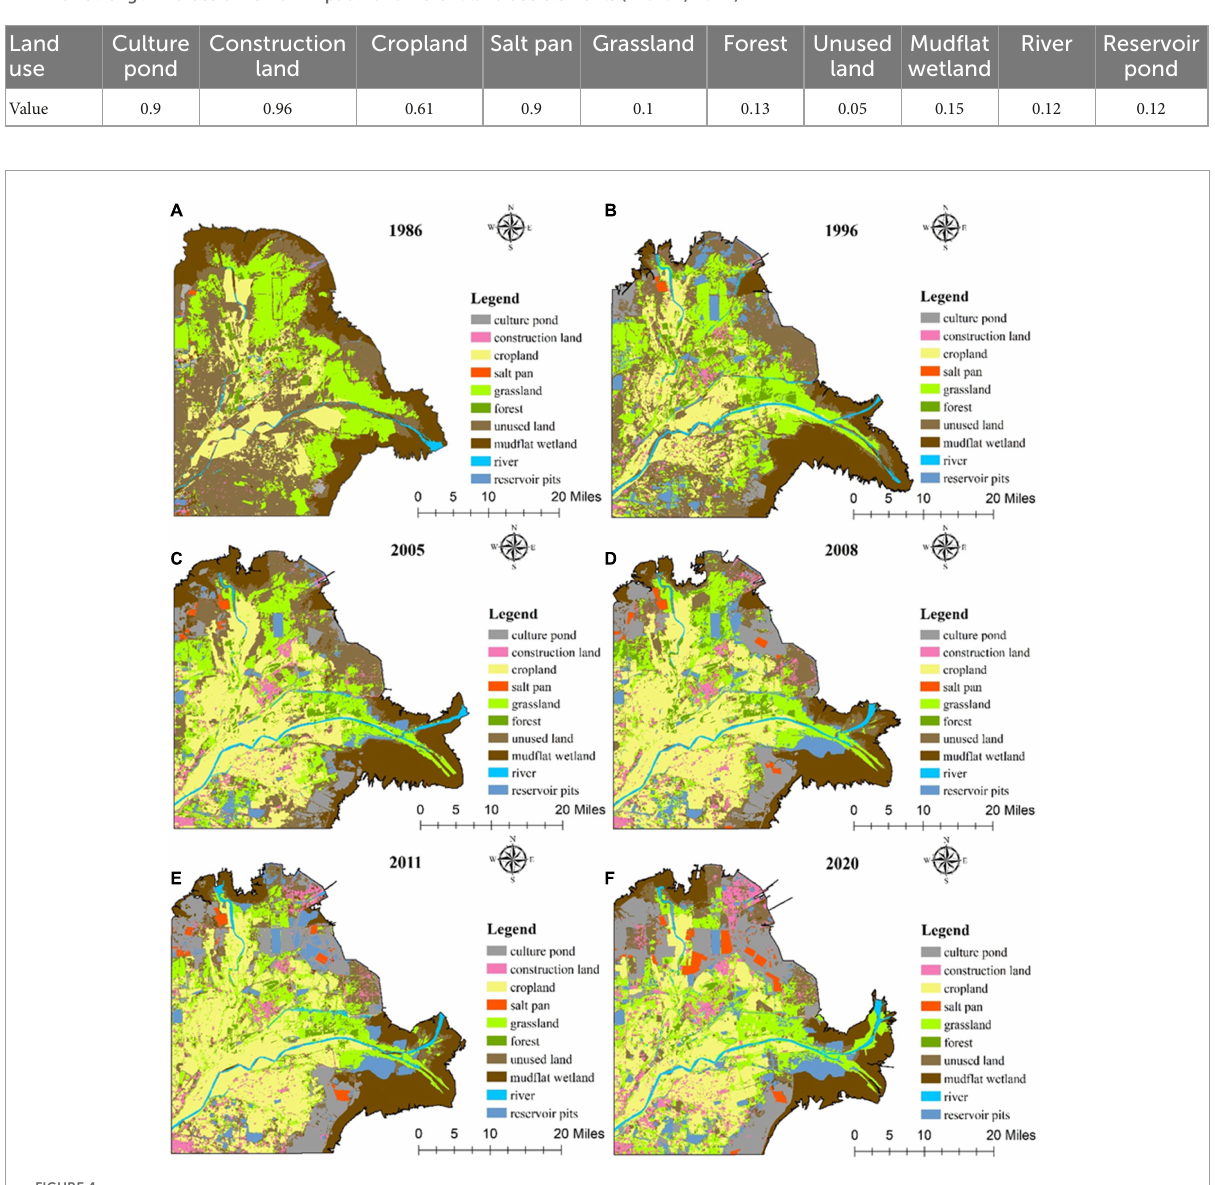
TABLE 3 Strength indices of human impact for different land use elements (Li et al.,